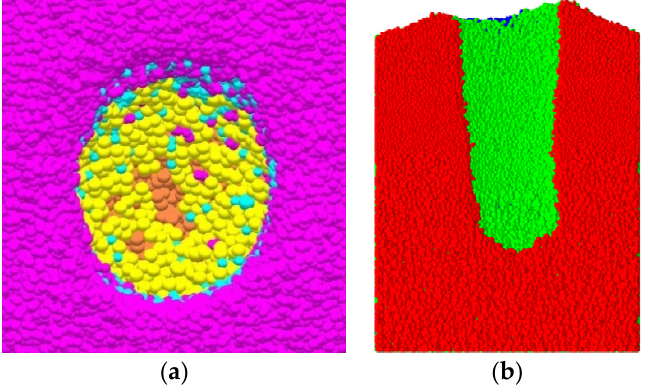
Figure 6. Three-dimensional shape of the well-cellar cavitation: ( a ) shape of the hole for the well-cellar cavitation; ( b ) sectional shape of the well-cellar cavitation.